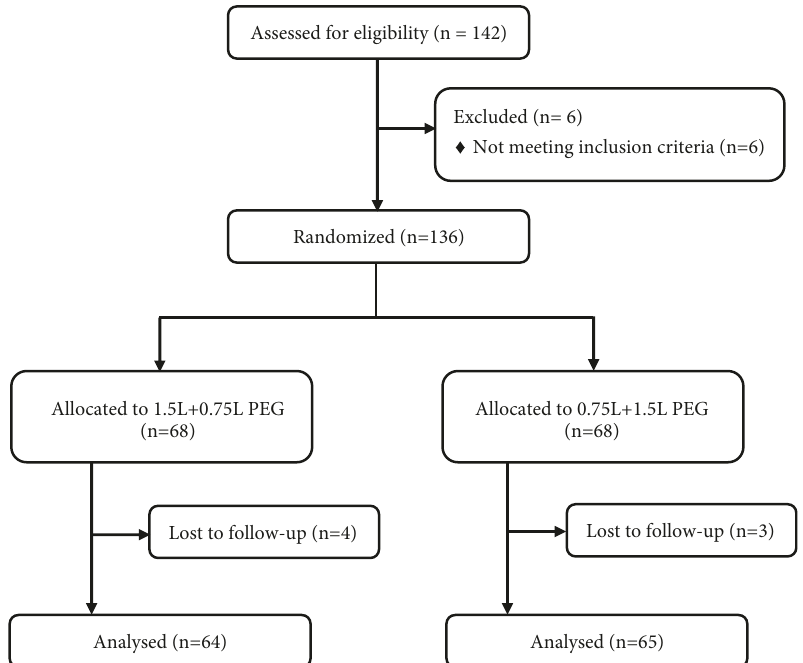
Figure 1: Flow diagram of the